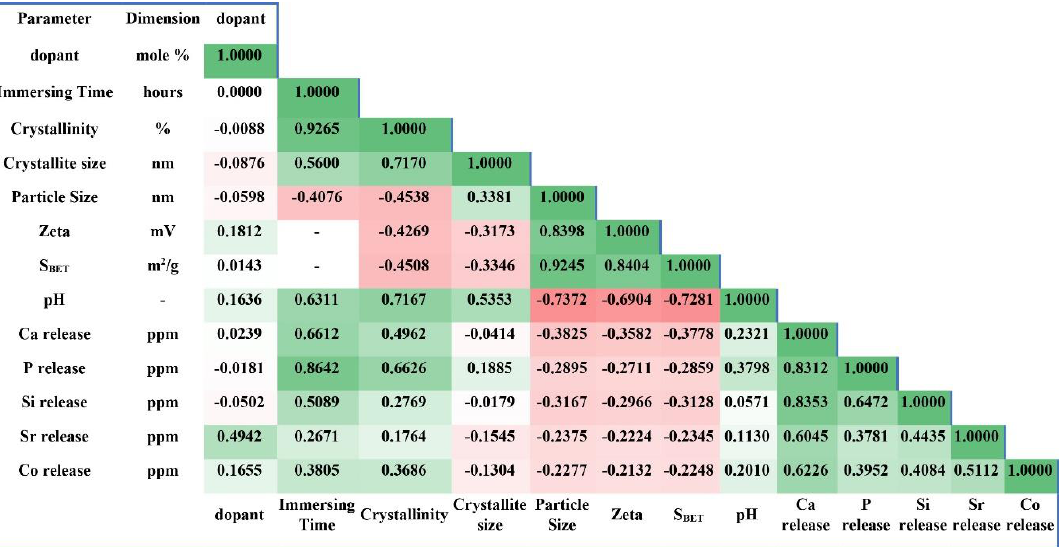
Figure 12. Results of cell migration study (HUVECs) after 24 h.